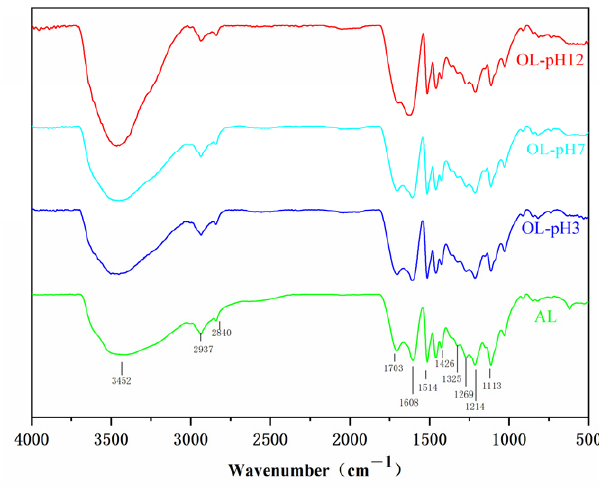
Figure 2. FTIR spectra of alkali lignin before and after ozone pretreatments. Table 2. The relative signal intensity of each functional group based on the 1514 cm − 1 band.